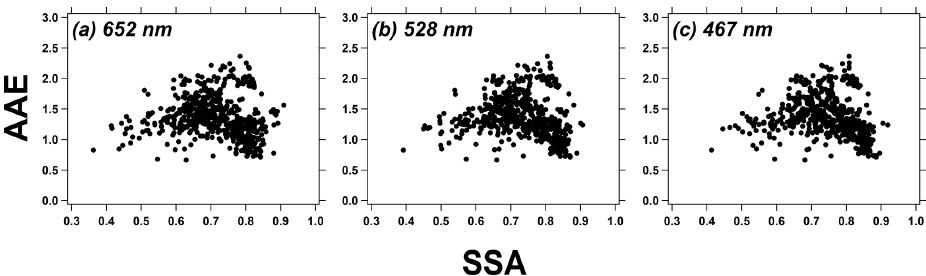
Figure 9. AAE plotted against SSA for the SGP ambient data. The power-law fit (AAE = a + b × SSA c ) is performed on SSA (SSA = B scat /(B scat + B ATN )) and AAE computed by three-wavelength B ATN .